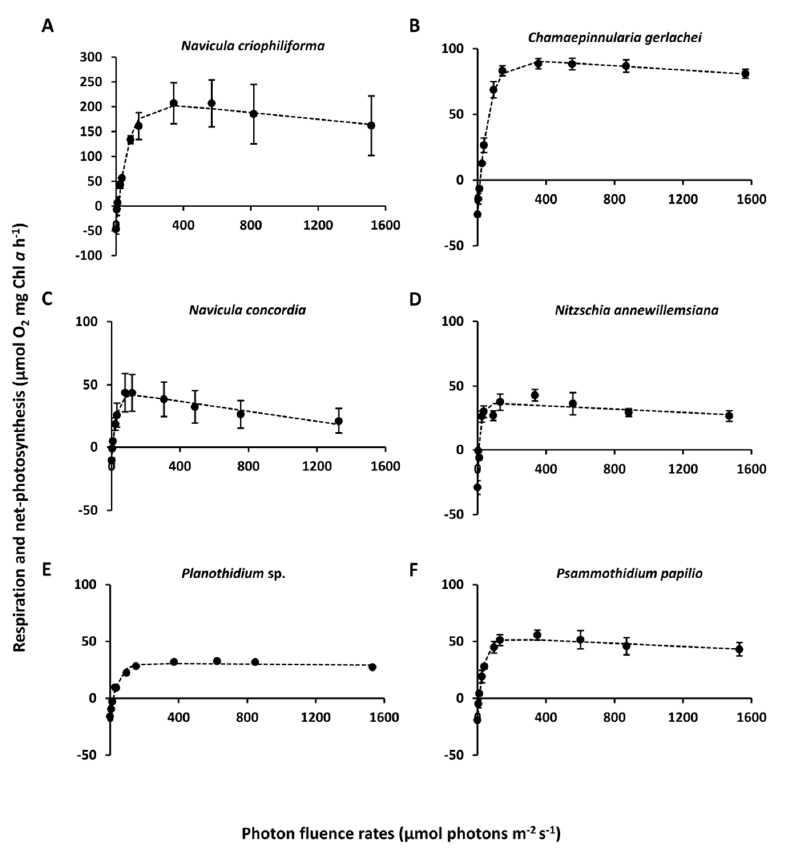
Figure 8. Photosynthesis and respiration rates ( µ mol O 2 mg − 1 Chl a h − 1 ) as a function of increasing photon flux density ( µ mol photons m − 2 s − 1 ) of six benthic diatom strains from Antarctica kept at 8 ◦ C in f/2 medium: 33 S A ( A – C ) and 1 S A ( D – F ). Data represent mean values ± SD ( n = 3). Data points were fitted using the model of Walsby [50]. ( A ) Navicula criophiliforma , ( B ) Chamaepinnularia gerlachei , ( C ) Navicula concordia , ( D ) Nitzschia annewillemsiana , ( E ) Planothidium sp., and ( F ) Psammothidium papilio . Table 3. Parameters of respective P–I curves (Figure 8) of six benthic diatom species ( n = 3) kept at 8 ◦ C. Different lowercase letters represent significance levels among all means as calculated by one-way ANOVA (Tukey’s test, p < 0.05). NPP max represents the maximal oxygen production rate, α is the initial slope of production in the light-limited range, β is the terminal slope of production in extensive light range (photoinhibition), I k is the light saturation point, and I c is the light compensation point.